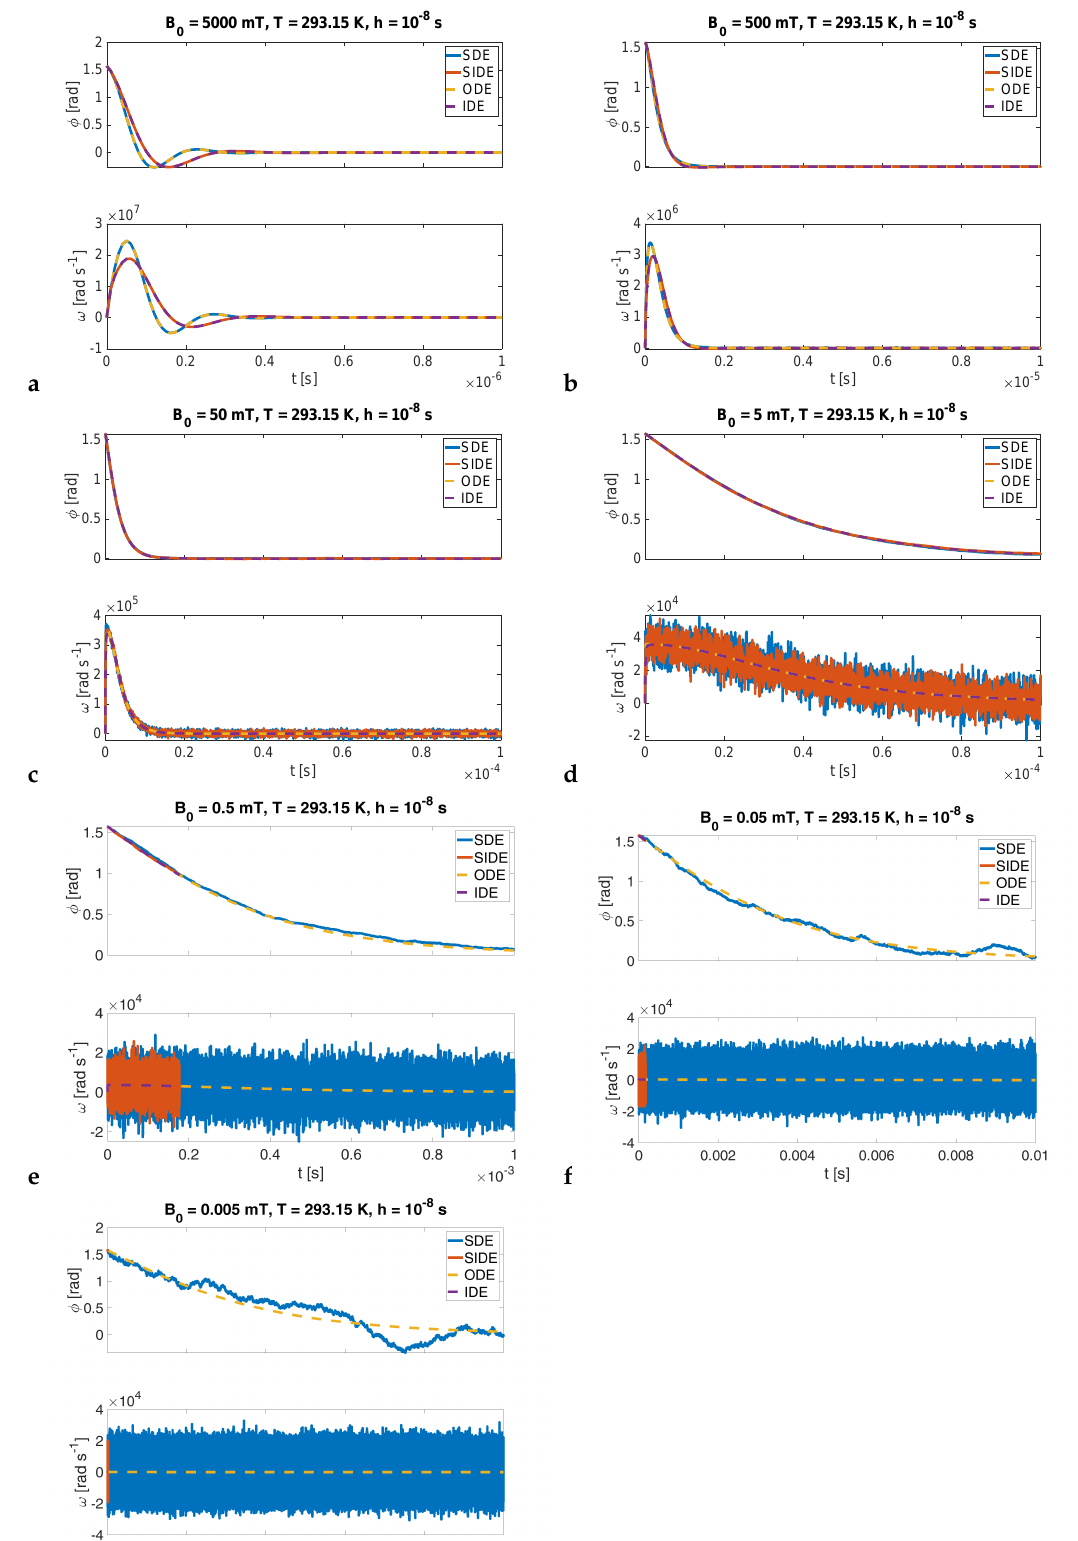
Figure 1. Comparison of all considered models of rotational magnetic particle alignment for B 0 from 5T down to 5 µ T in panels ( a – g ), respectively. In the weakest B 0 fields (panels ( e – g )), premature stopping of simulations for SIDE and IDE models occurs due to a math range error in the numerical evaluation of the f ( x ) = exp ( x ) function occurring in the kernel function